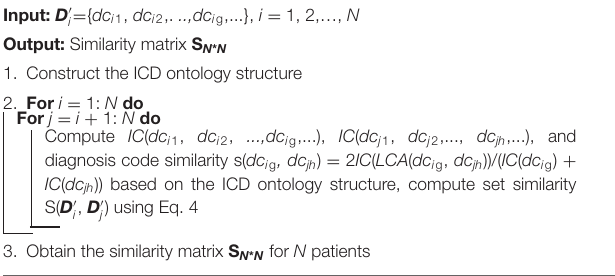
Algorithm 1 | Patient similarity measure